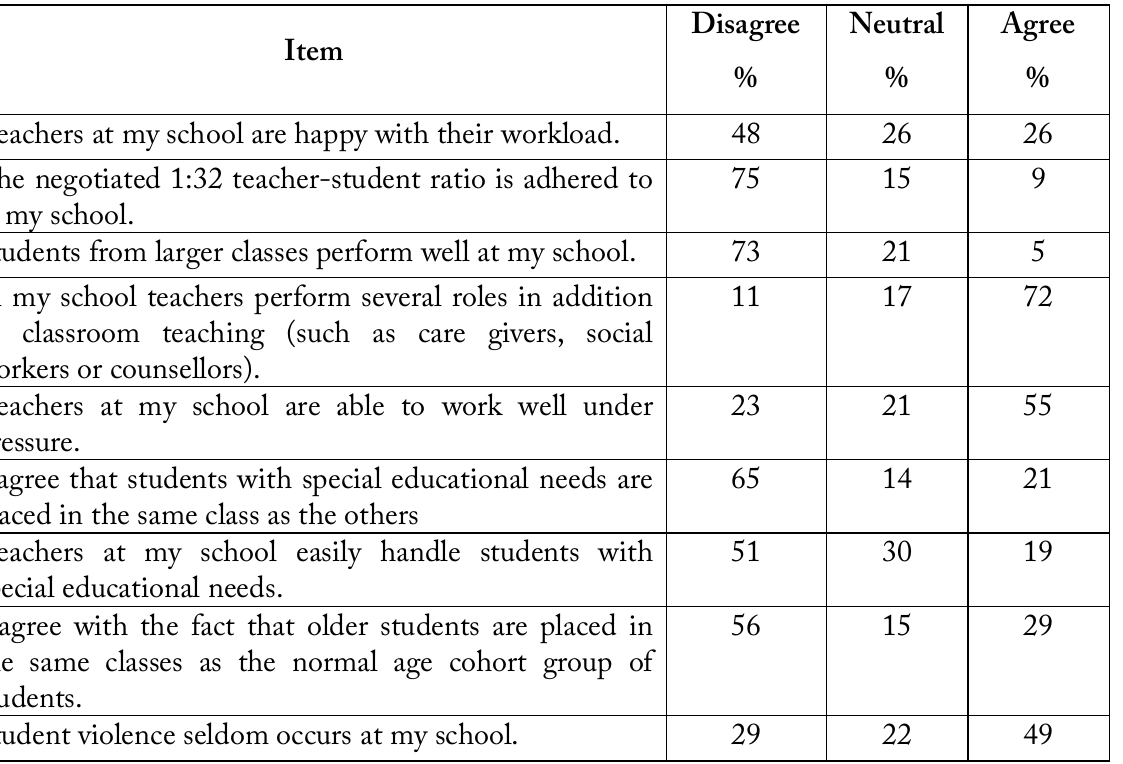
Table 5: Perceptions of job demands